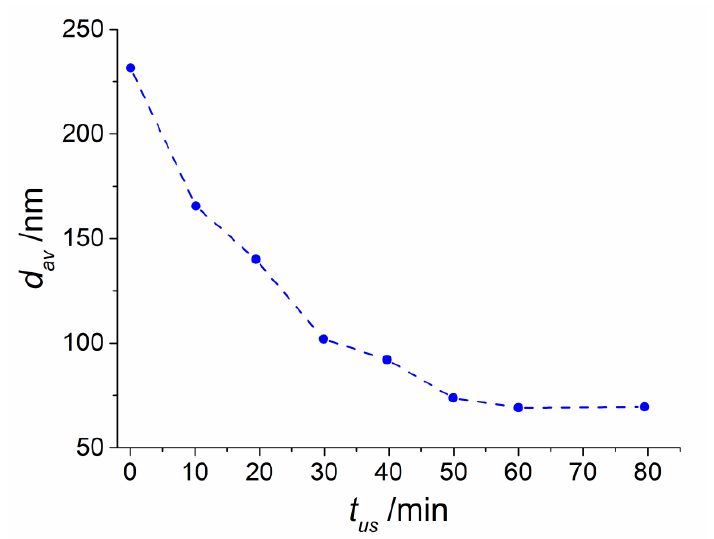
Figure 1. Dependence of the SFMO agglomerate size on sonication time.